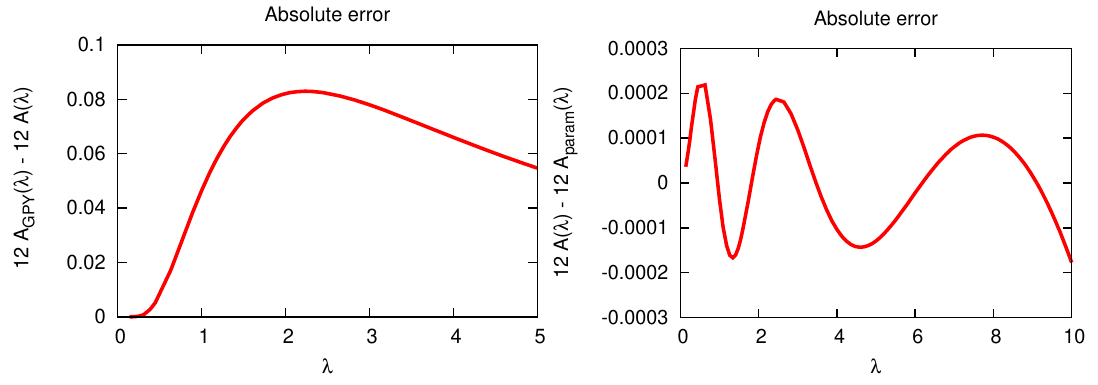
Figure 3 . Left: the di(cid:11)erence between (2.9) and our numerical result. Right: the di(cid:11)erence between the parametrization (4.7) and the numerical